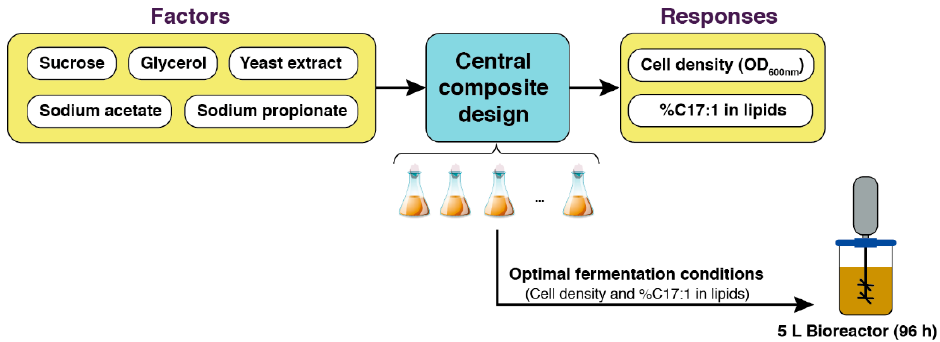
Figure 1. Experimental set-up for the optimization of culture conditions to maximize cell density (OD 600 nm ) and the C17:1 content (%) in lipids.